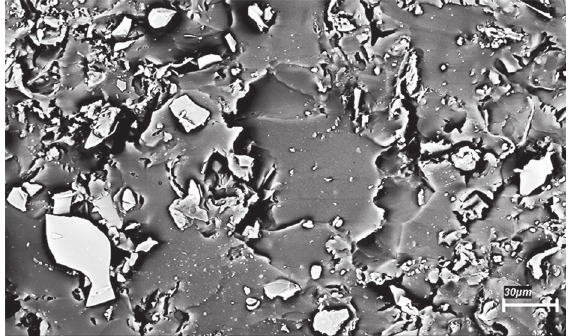
Figure 2 - SEM micrograph of dispersion of perlite particles in HTPB matrix.